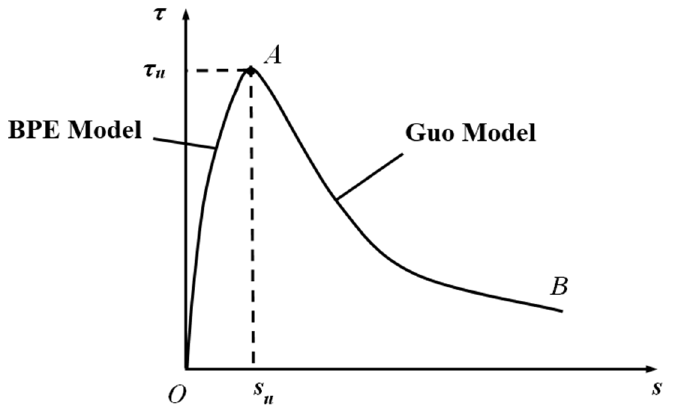
Figure 13. Bond–slip relationship model.